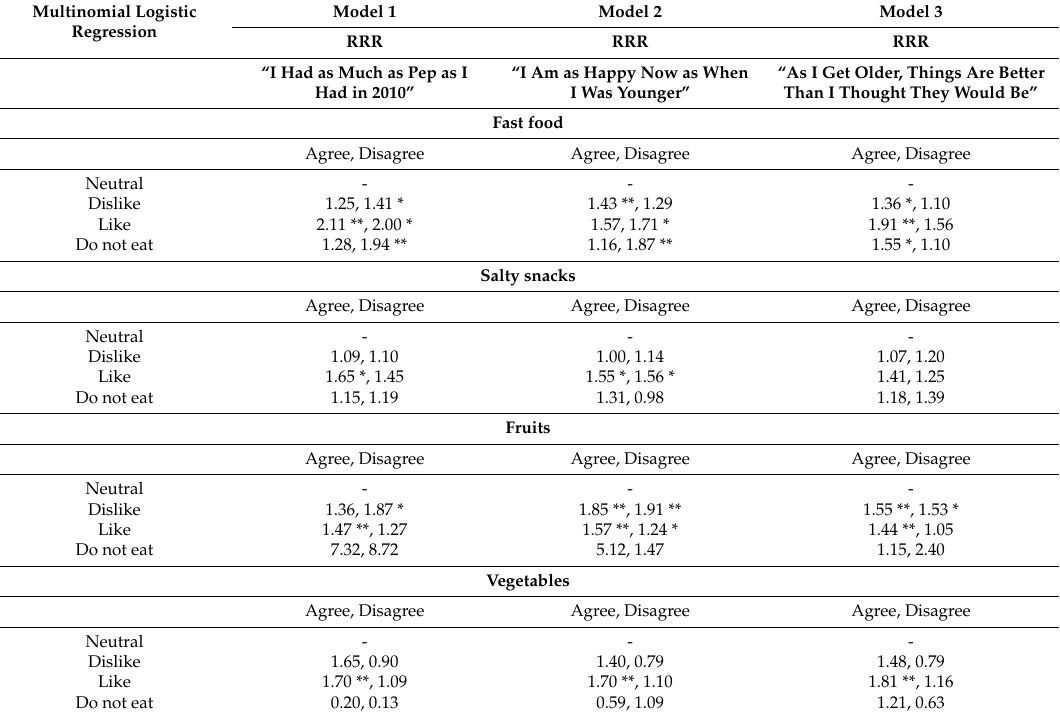
Table 4. Relative risk ratios (RRR) estimated by multinomial regression models on associations between five food preferences and psychological well-being measures adjusted with all covariates. Data: China Health and Nutrition Survey,